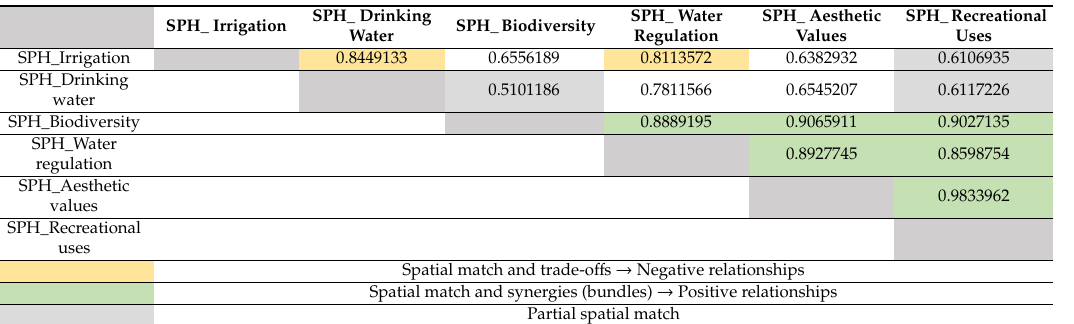
Table 6. Spatial correlation between provisioning water ecosystem service hotspots (SPH) generating trade-o ff s. Yellow color represents trade-o ff s; green color represents synergies (bundles); grey color represents partial spatial